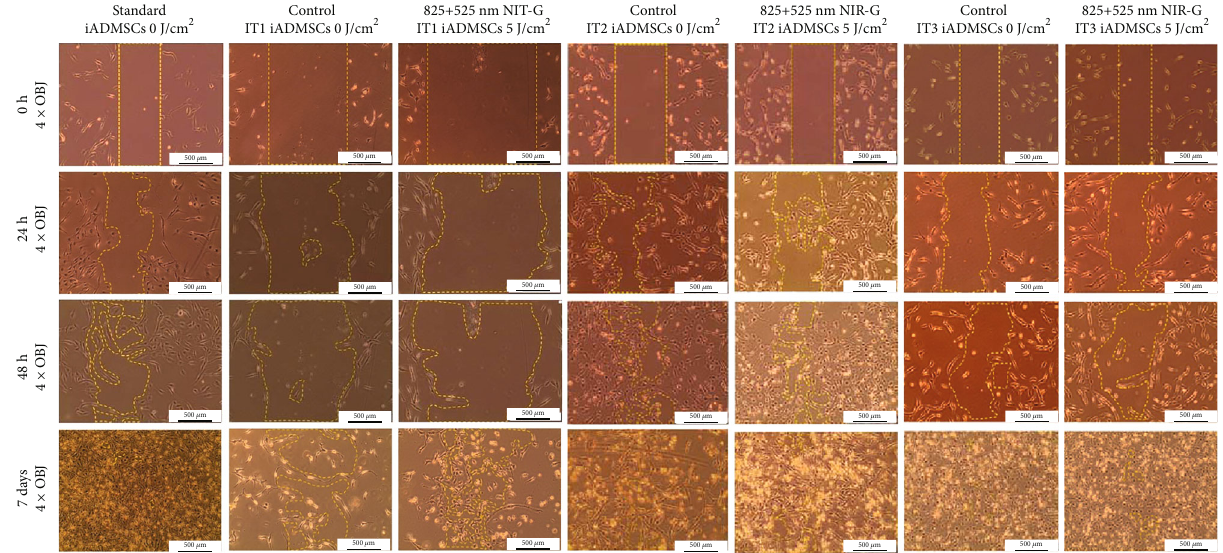
Figure 6: Migration of transdi ff erentiated iADSCs 0 h, 24h, 48 h, and 7 days post-PBM. Shown here are the untreated standard iADSCs, untreated IT1 control cells, experimental IT1 iADSCs exposed to NIR-G PBM consecutively, untreated IT2 control cells, experimental IT2 iADSCs exposed to NIR-G PBM consecutively, untreated IT3 control cells, and experimental IT3 iADSCs exposed to NIR-G PBM consecutively. Scale bar: 500 μ m.